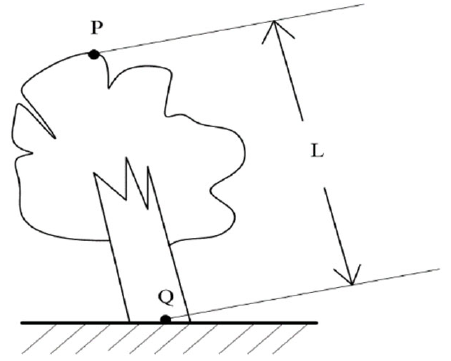
Figure 5. Schematic of seedling height.